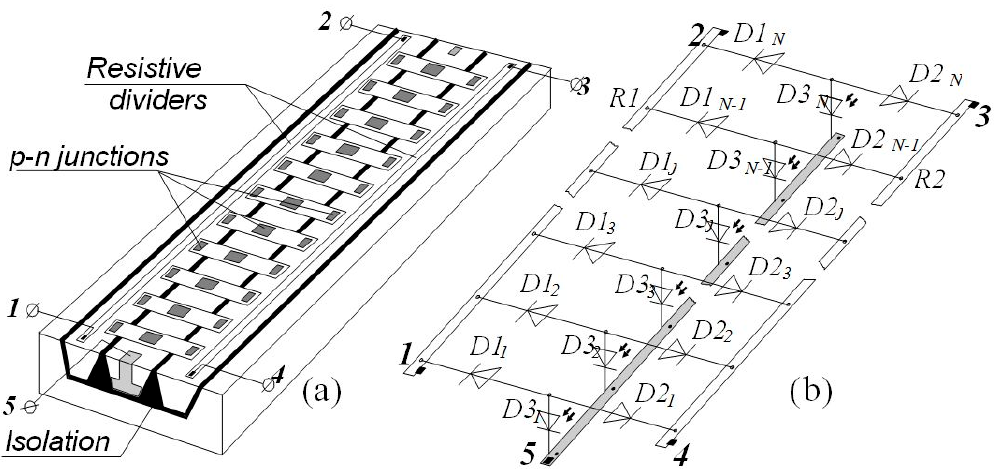
Figure 1. ( a ) General view of the multiscan; ( b ) its equivalent scheme.